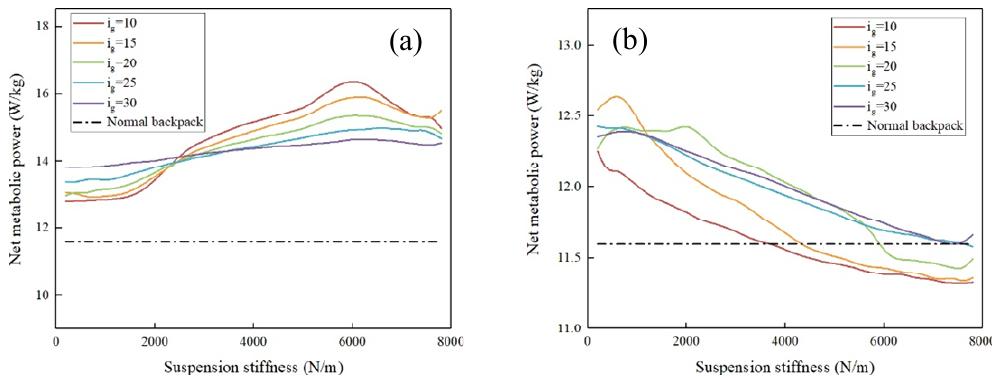
Figure 4. Net metabolic power versus spring stiffness under different gear ratios with walking velocity v = 5.5 km / h and load mass m l = 15 kg: ( a ) Slip model; ( b ) Swing model.